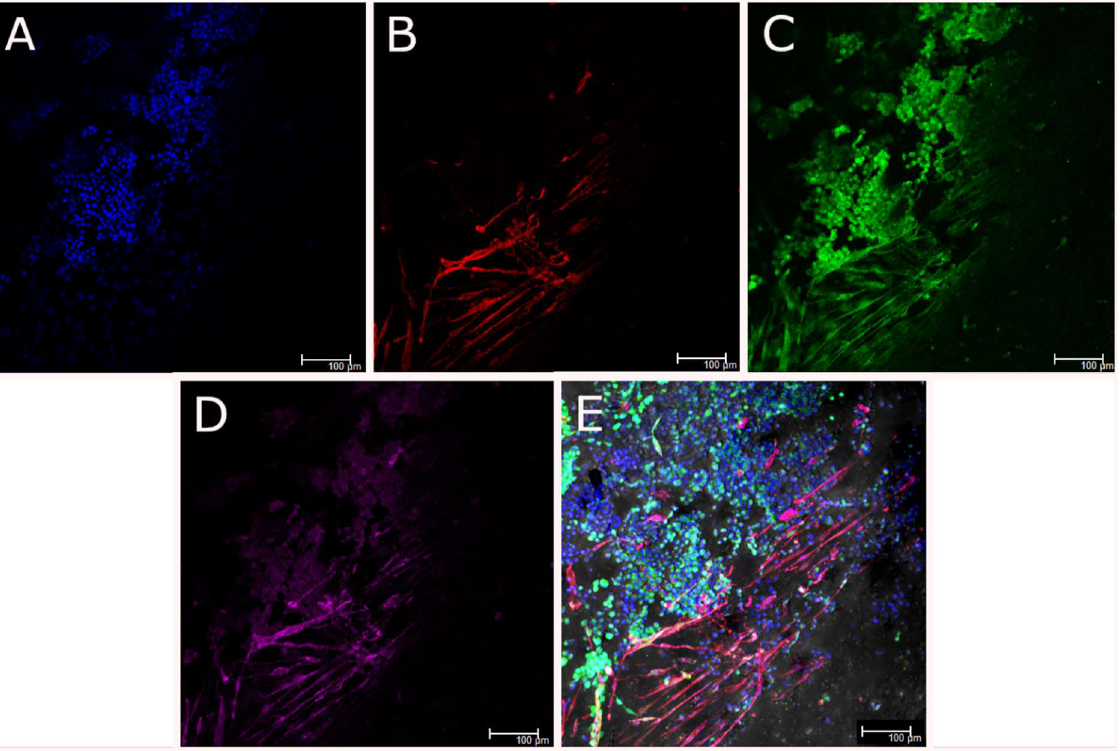
Figure 11. Coaxially-printed skeletal muscle and motor neuron cells, fixed and immunostained for nuclei (DAPI, blue, A ), α-sarcomeric actinin (red, B ), βIII tubulin (green, C ) and neuromuscular junctions (α-bungarotoxin, magenta, D ). Image E is an overlay of A , B , C and D E . Scale bars represent 100 µm.